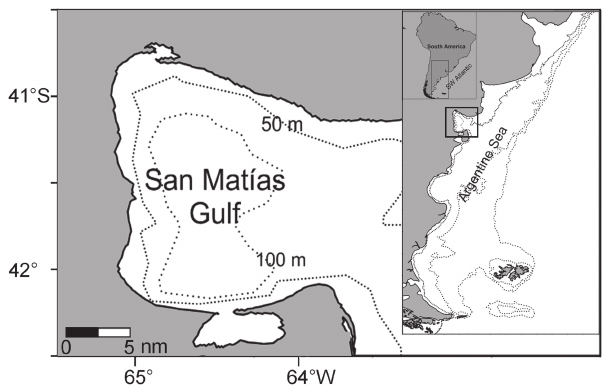
Fig. 1. Geographic location of the study area, San Matías Gulf